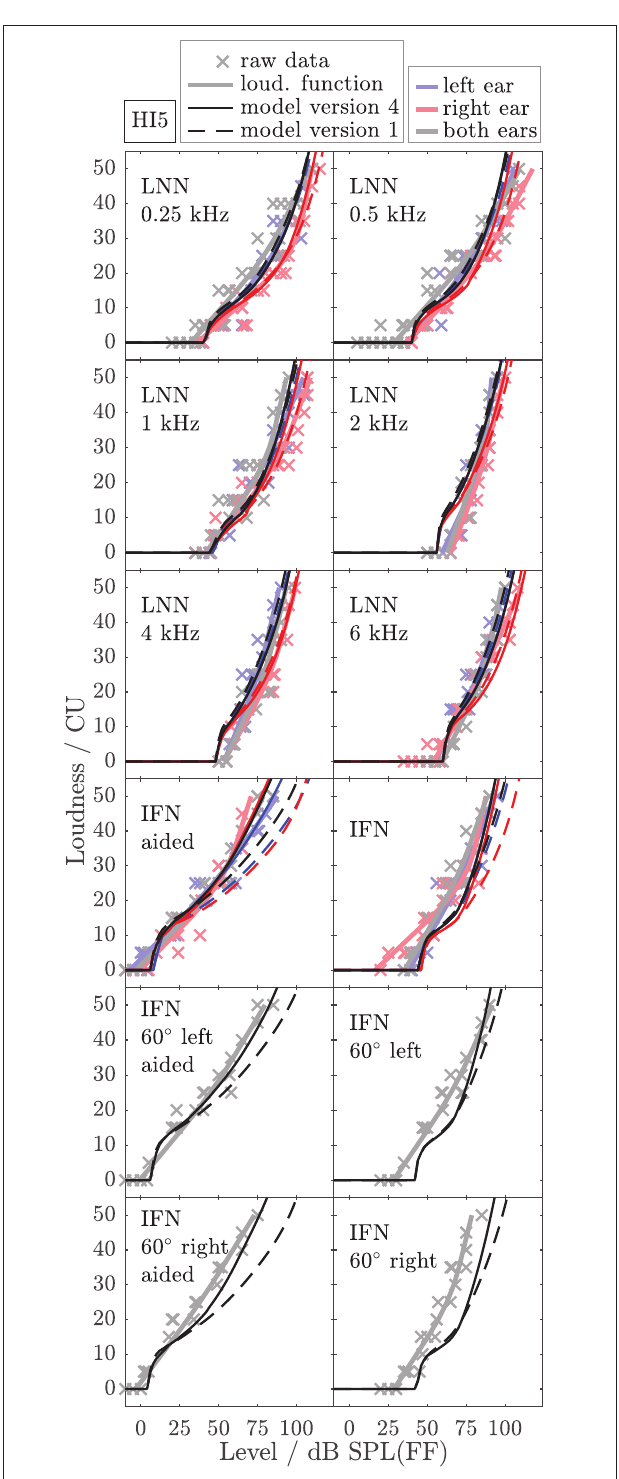
FIGURE 6 | Empirical loudness functions of listener HI5 (brightened thick solid lines) and modeled loudness (thin lines) for monaural conditions (left ear: blue, right ear: red) and diotic conditions (gray/black) with simulated frontal sound incidence or from ± 60 ◦ in the horizontal plane as indicated in the panels.